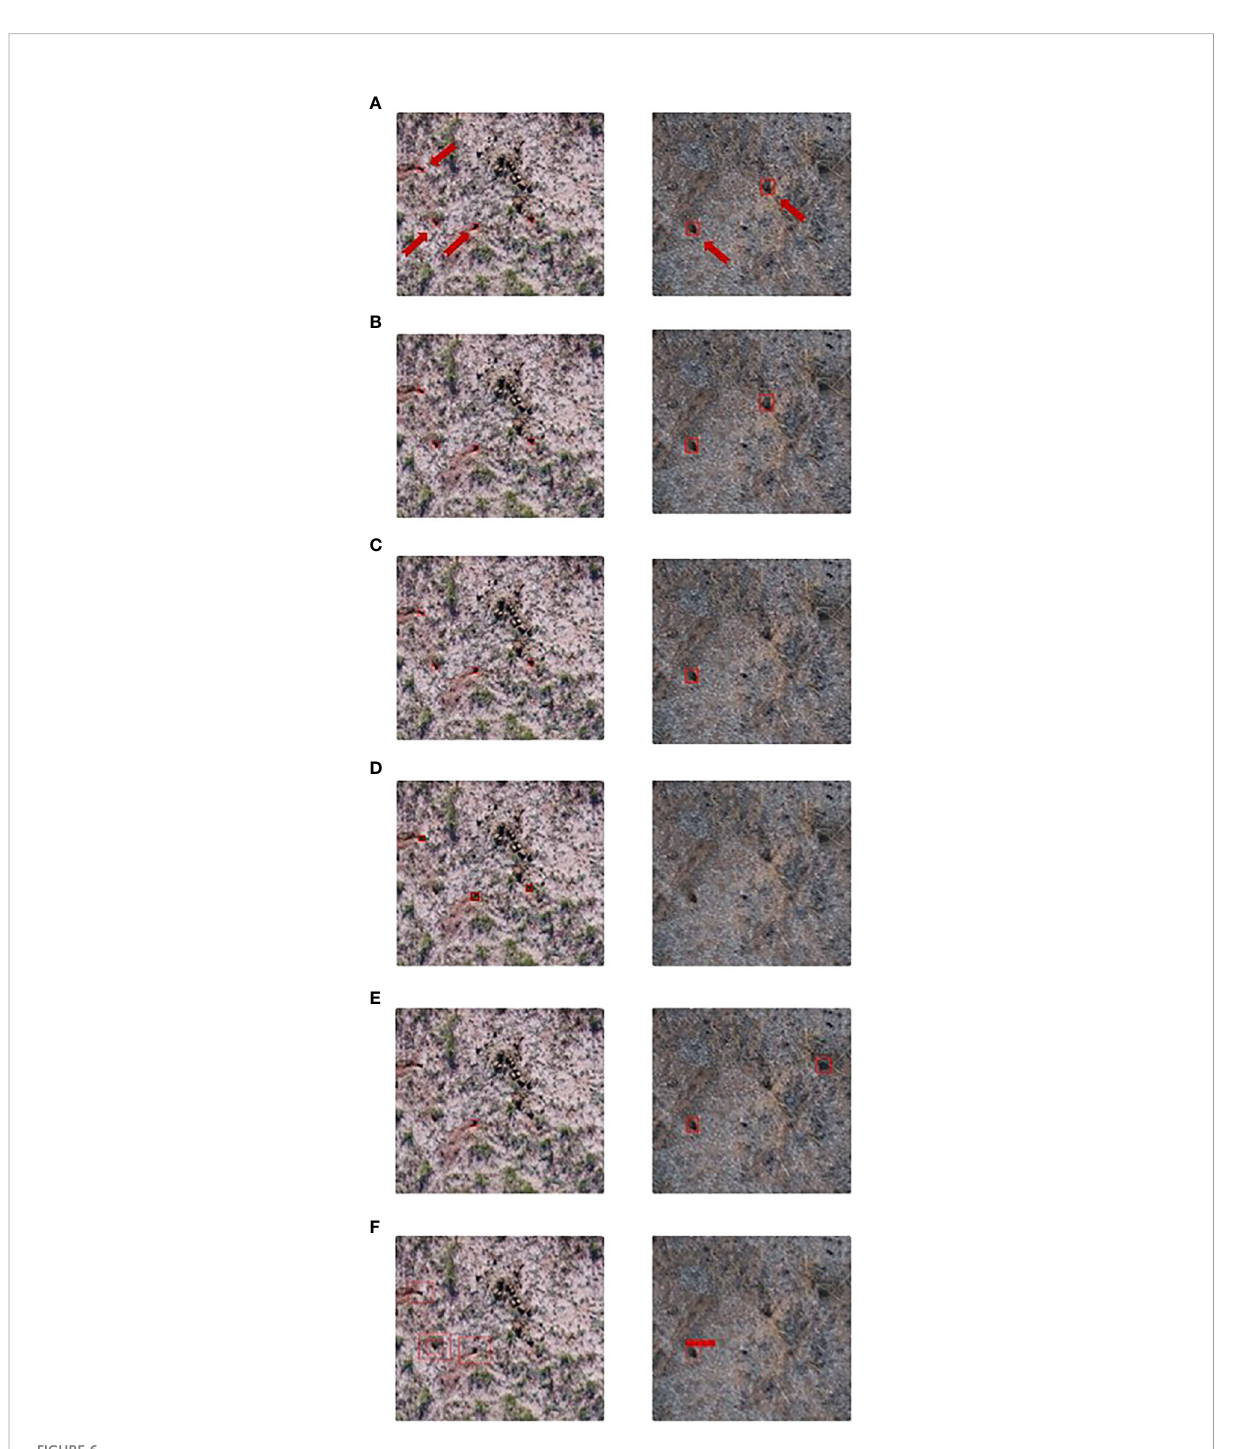
FIGURE 6 Test samples of BV hole detection using Deep-Learning (DL) algorithms in UAS images (left: summer samples, right: winter samples). (A) Faster R-CNN, (B) Cascade R-CNN, (C) R-FCN, (D) SSD, (E) RetinaNet, and (F) YOLOv4. Predicted BV holes are in red circles. Actual holes are pointed out using red arrows (A)